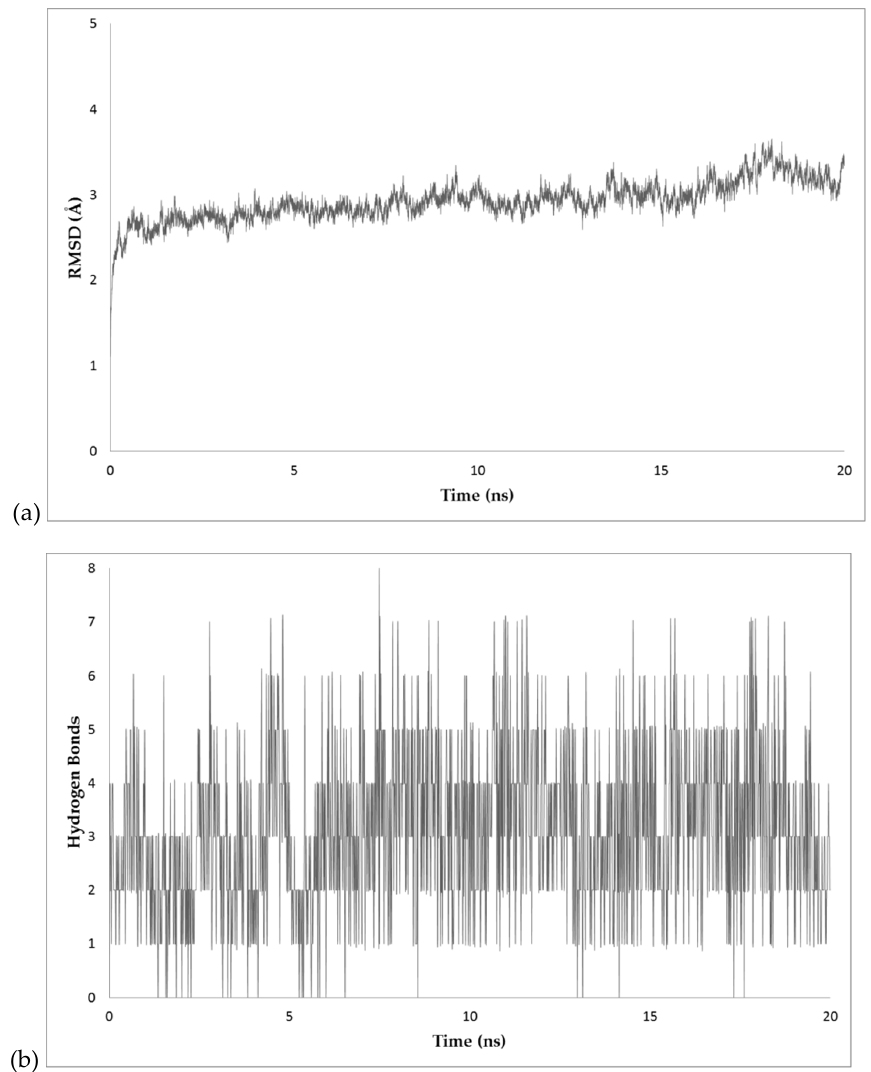
Figure 5. Predicted interactions during EMD simulation. ( a ) RMSD of BvrR protein docked to DNA by C -terminal effector domain with respect to the initial structure during 20 ns simulation. ( b ) Intermolecular hydrogen bonds between the C-terminal domain and DNA during 20 ns simulation. Data were obtained and analysis was performed with VMD software [43].